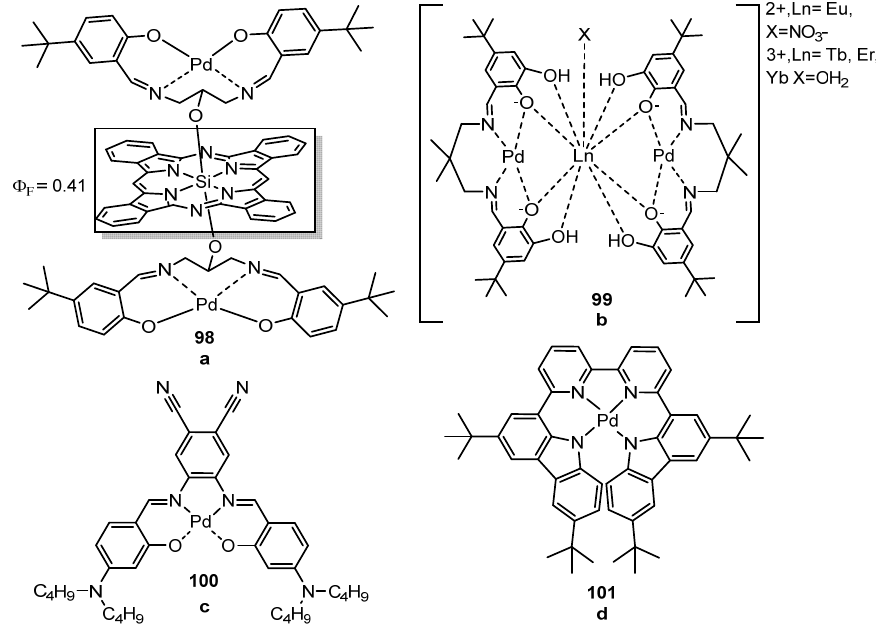
Figure 28. Pd(II) coordination complexes containing tetradentate Sch ff bases as ligands in polynu- clear (a,b) and mononuclear (c,d) environments. Adapted from